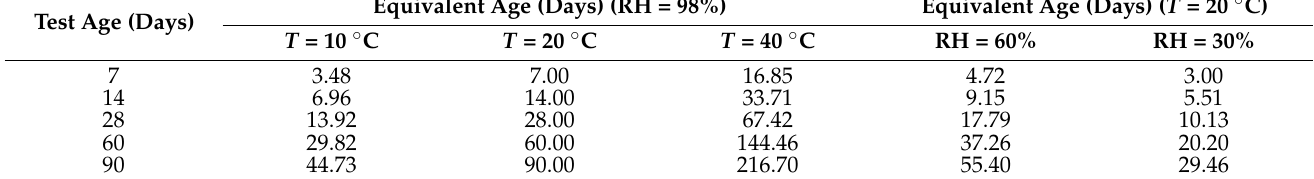
Table 6. Equivalent age of environmental chamber-cured concrete specimens.